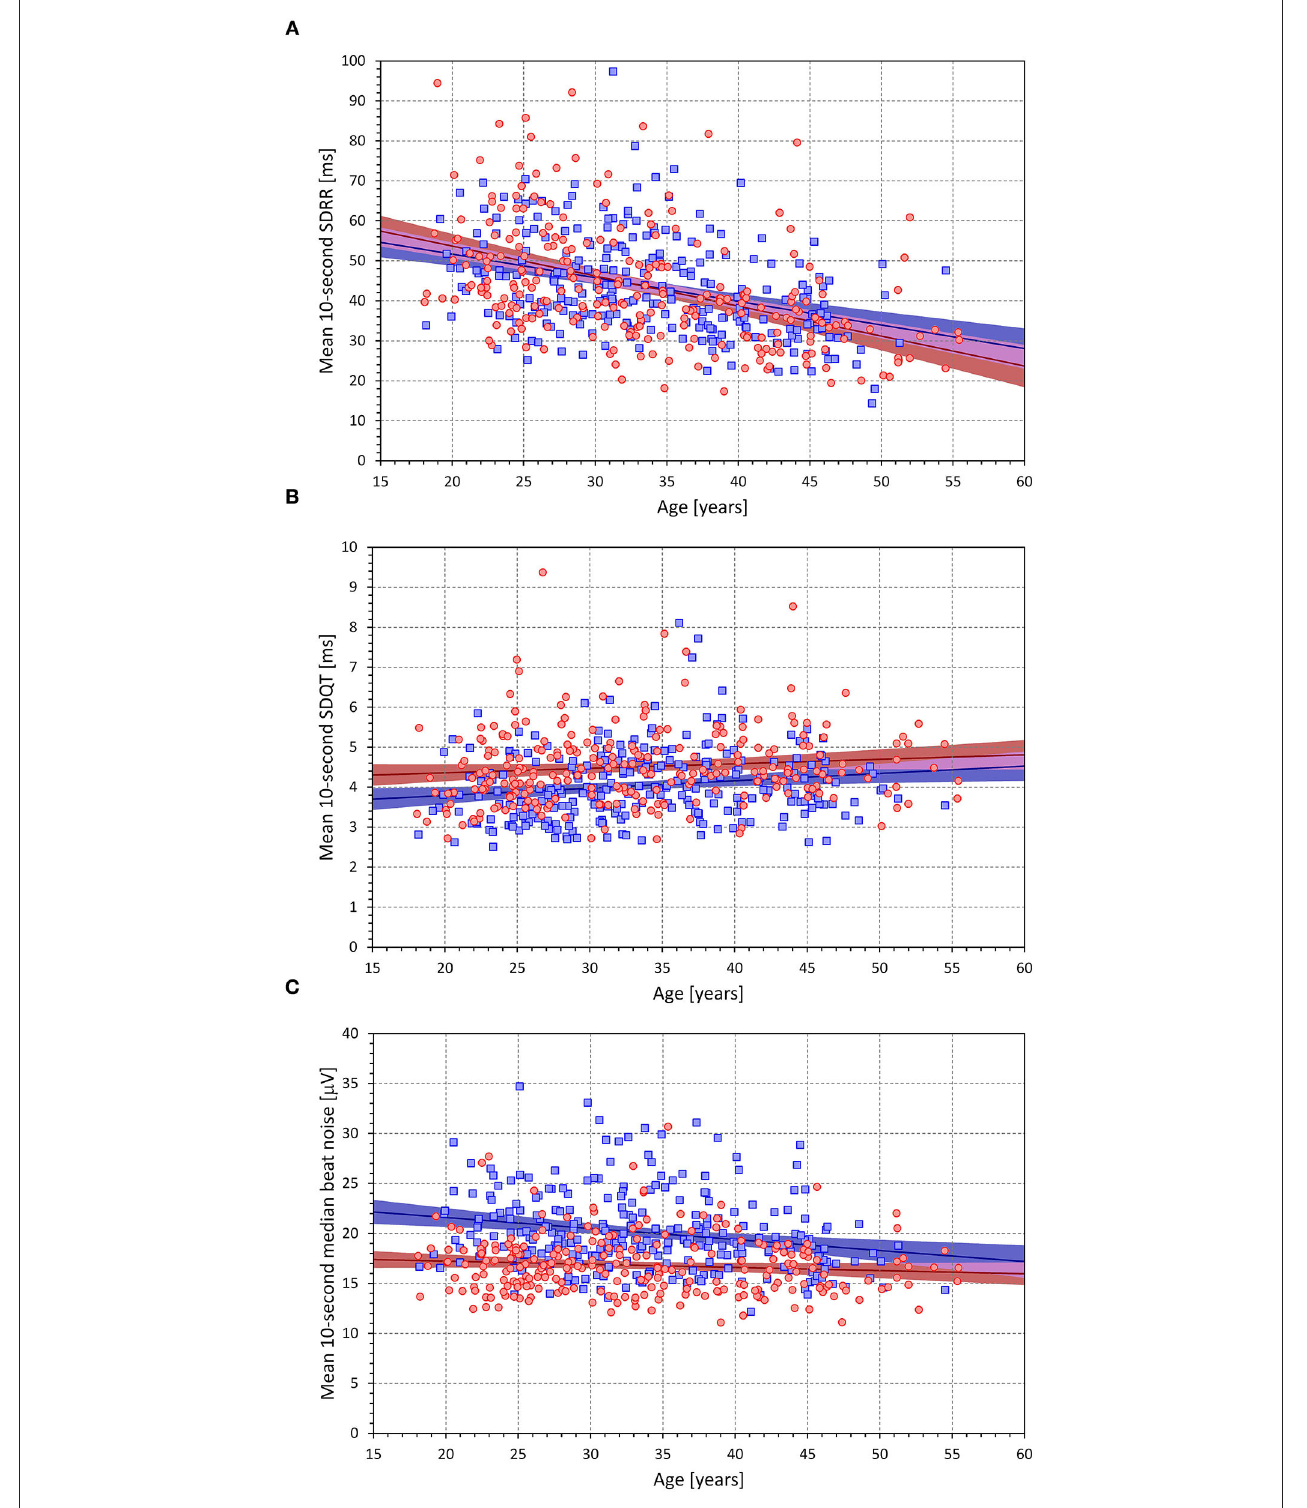
FIGURE 7 | The figure shows age influence on intra-subject means of 10-s SDRR [upper (A) ], 10-s SDQT [middle (B) ], and 10-s median beat noise [bottom (C) ]. In each panel, the red circle and blue square marks correspond to females and males, respectively. The red and blue lines show the linear regression models between the displayed characteristics and age, the light colored red and blue bands show the 95% confidence intervals of the linear regressions, the light-colored violet areas show the overlaps between the regression confidence intervals of both sexes.